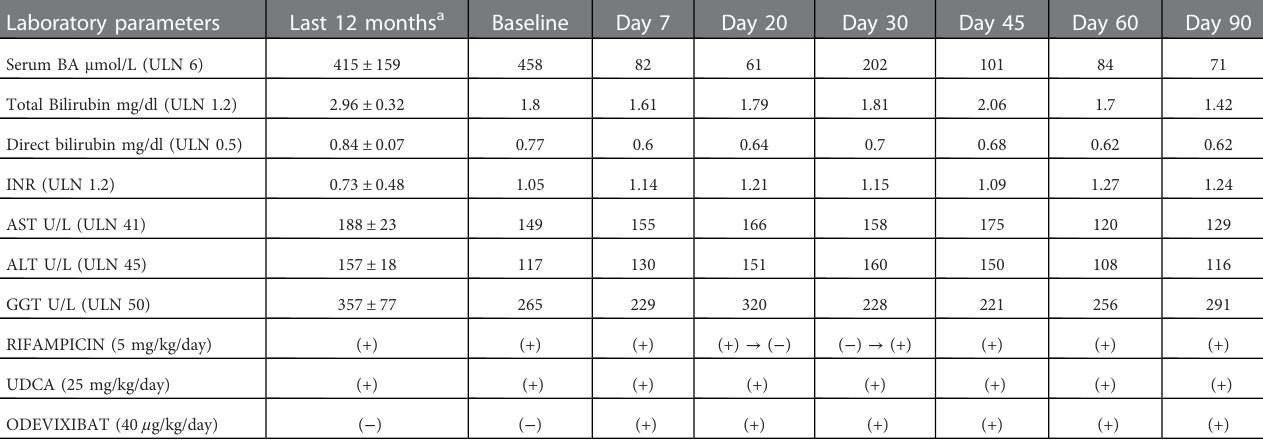
TABLE 1 Serum levels of liver enzymes, bilirubin and serum bile acids, and INR before and during odevixibat treatment. Laboratory parameters